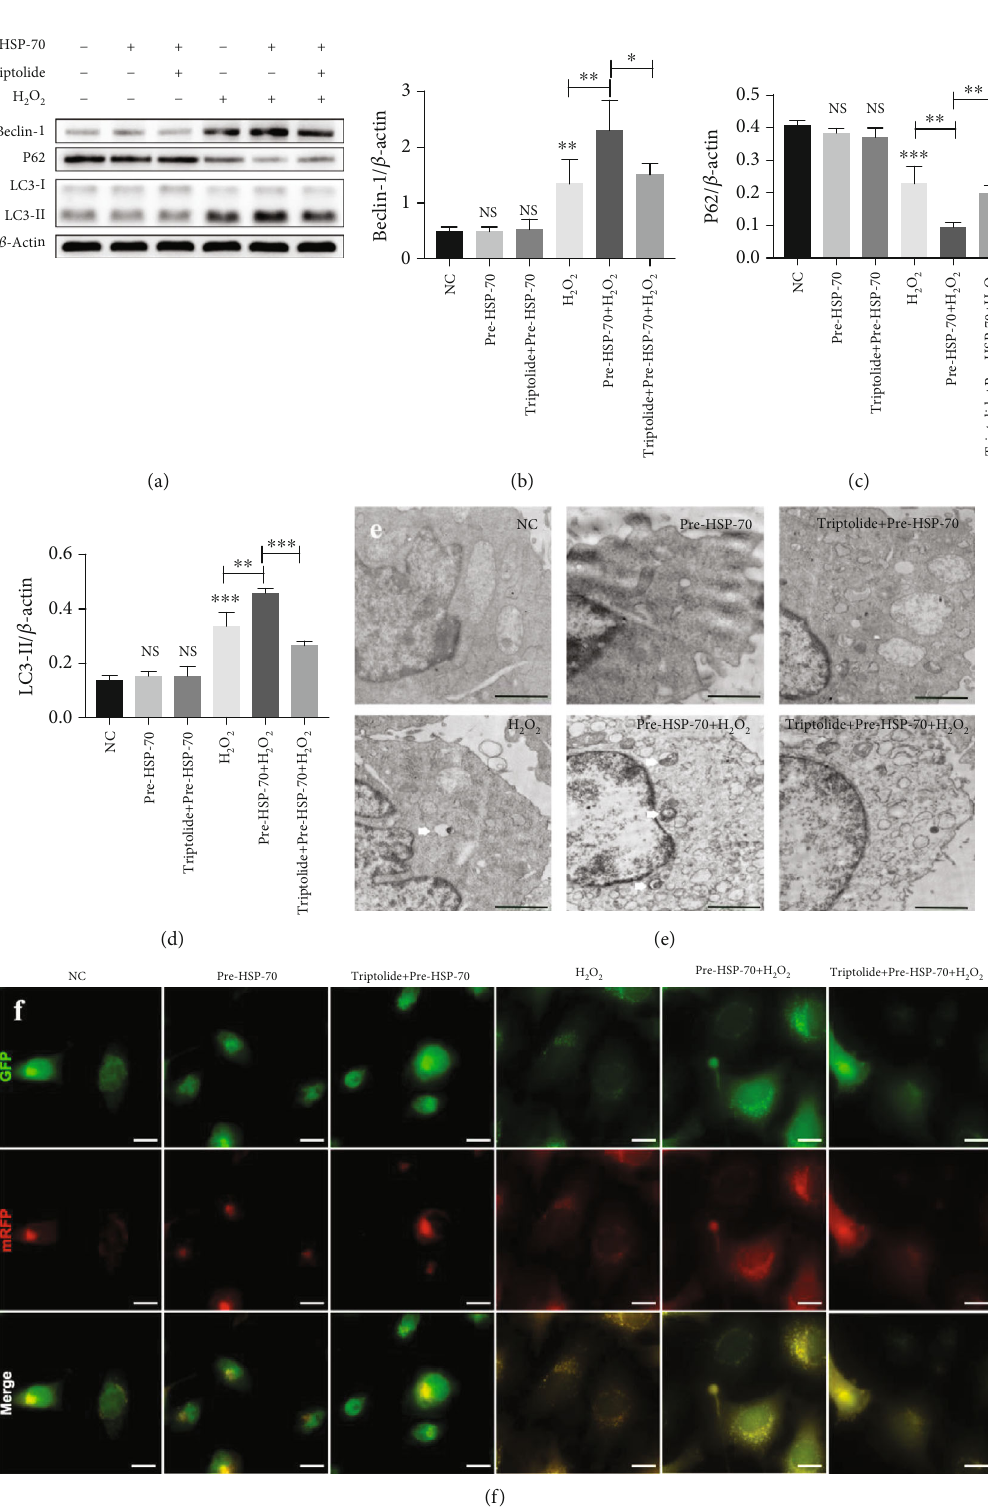
Figure 7: HSP-70 increased the level of cell autophagy after H O stimulation. (a – d) Representative western blot images showing the protein 2 2 levels of LC3, Beclin-1, and P62. β -Actin was used as an internal control. (e) Autophagosomes (white arrow) were detected by tandem fl uorescent mRFG-GFP-LC3 assay, scale bars: 15 μ m. (f) Autophagosomes were measured by TEM in four groups. Every experiment was repeated at least three times, scale bars: 2 μ m. Error bars indicate mean ± SD ( ∗ P < 0 : 05 ; ∗∗ P < 0 : 01 ; ∗∗∗ P < 0 : 001